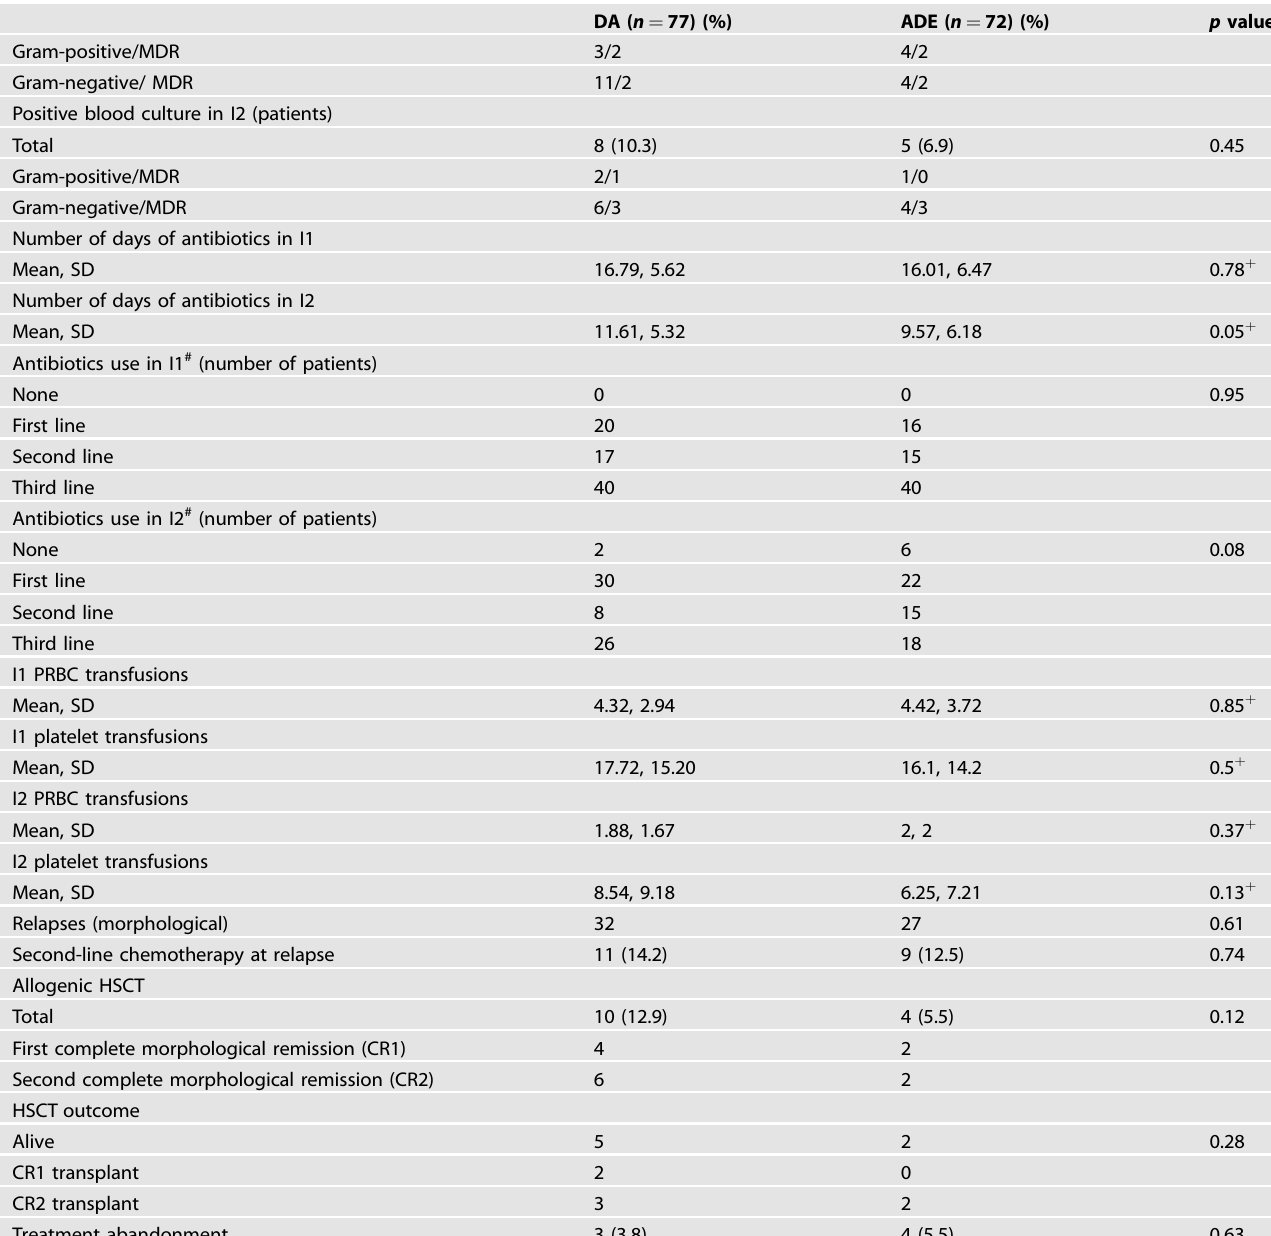
pancytopenia) and three patients in the ADE arm (one patient developed appendicitis and the other two had poor performance status due to septic shock) did not receive the second induction. They were planned for three HIDAC consolidations. One patient